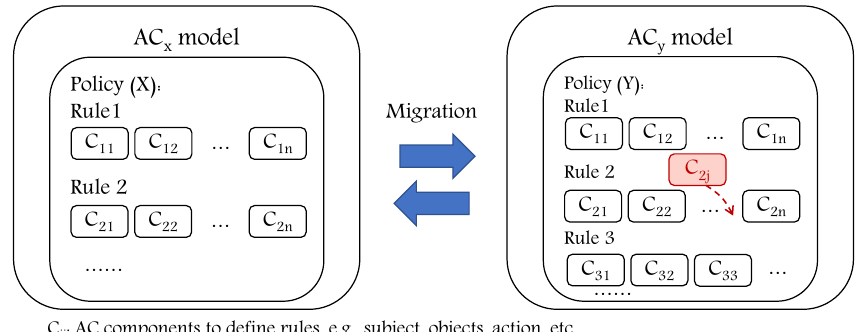
Figure 12. The concept of migration from one AC model to